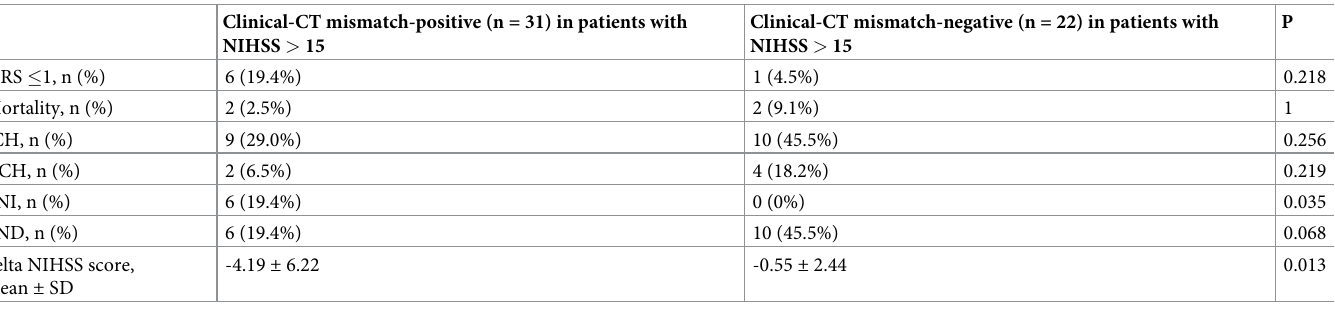
Table 4. Clinical outcomes of patients with severe (NIHSS > 15) stroke symptoms receiving intravenous thrombolysis: classification by clinical-CT